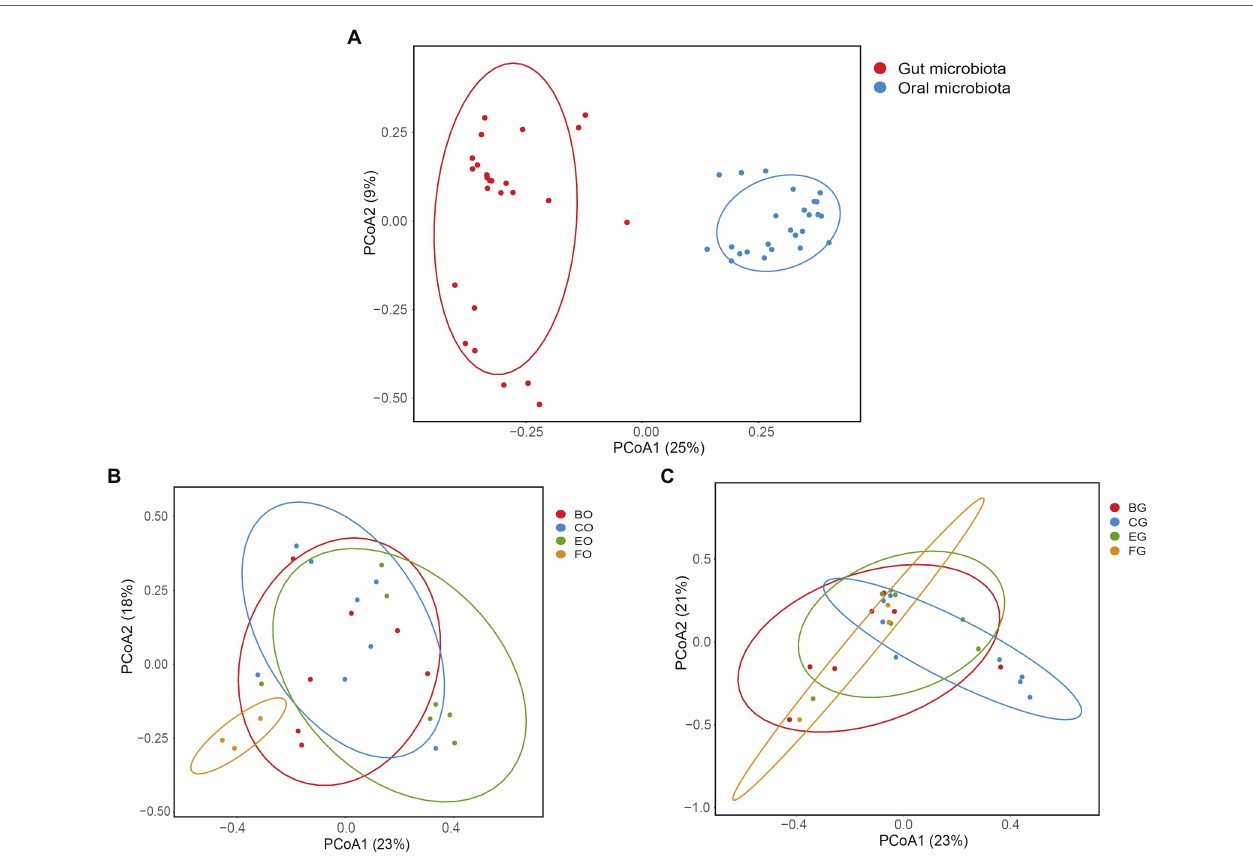
FIGURE 3 | Oral and gut microbial diversity in the eight groups (A) , and the oral (B) and gut (C) microbial diversity among animal groups. Principal coordinates analysis of Bray-Curtis distance matrix for bacterial community diversity. See Figure 1 for the definition of every